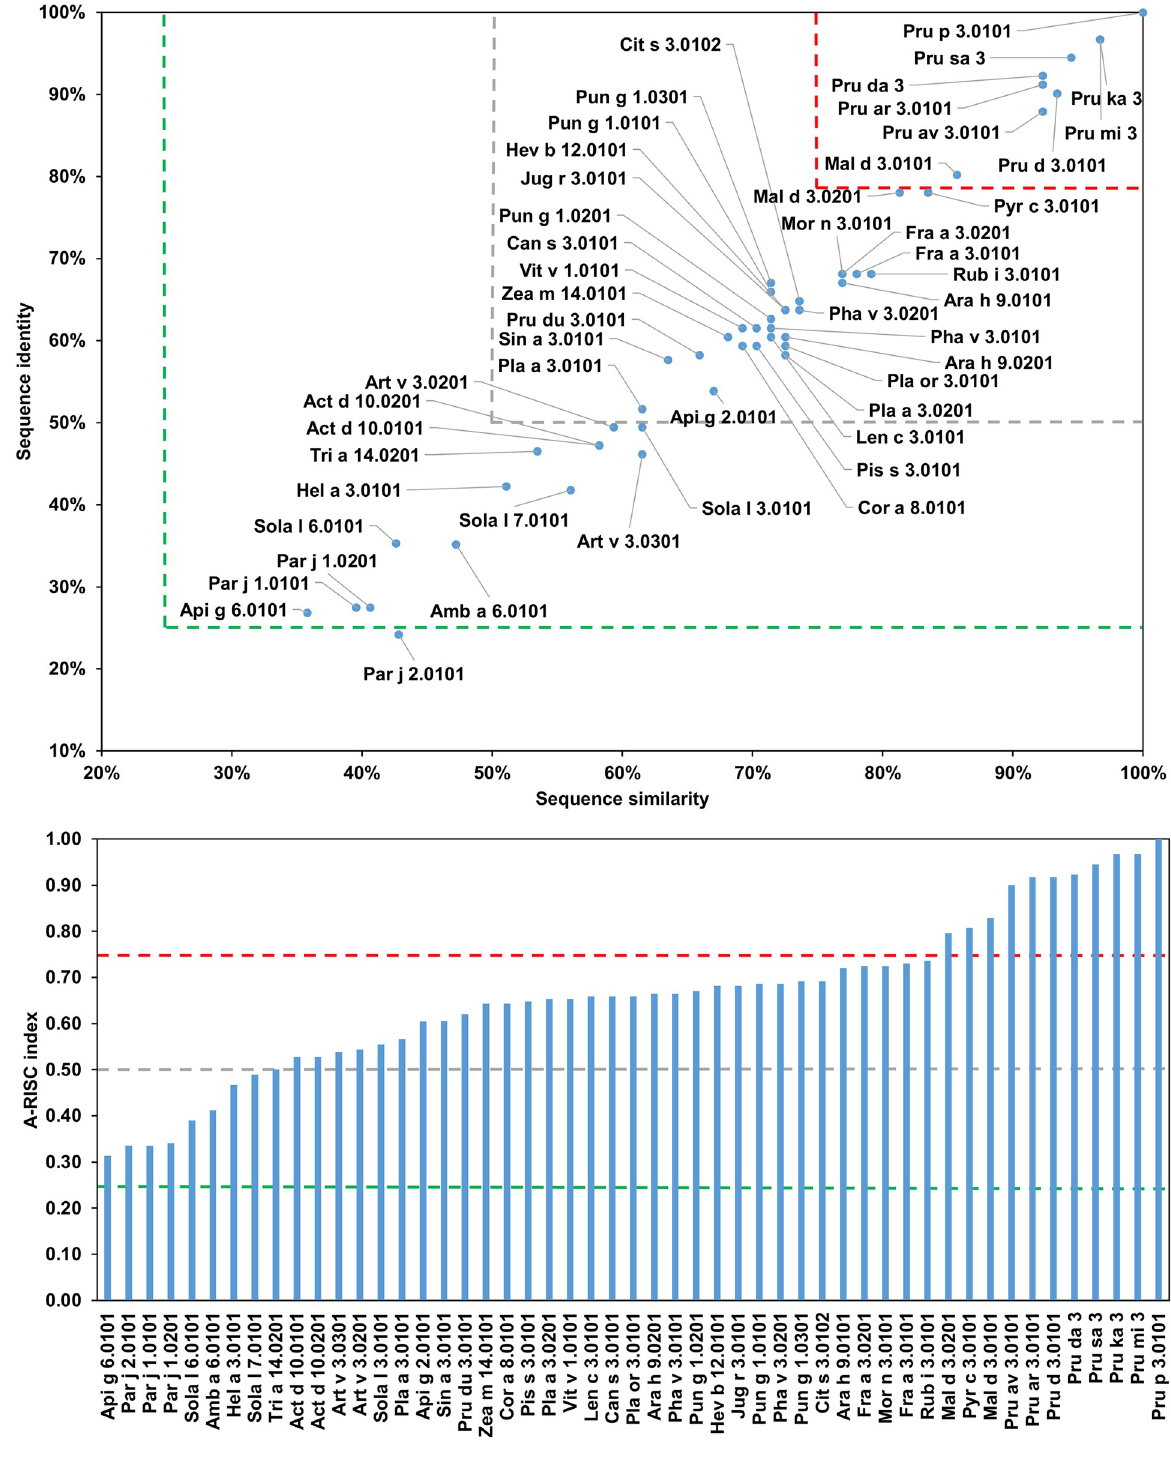
Fig 24. Plots showing relative homology and A-RISC indexes of allergens from nsLTP family. Comparison of the family members to Pru p 3.0101. Red, gray and dark green dashed lines indicate respectively 75%, 50% and 25% sequence identity and similarity, or 0.75, 0.50 and 0.25 A-RISC